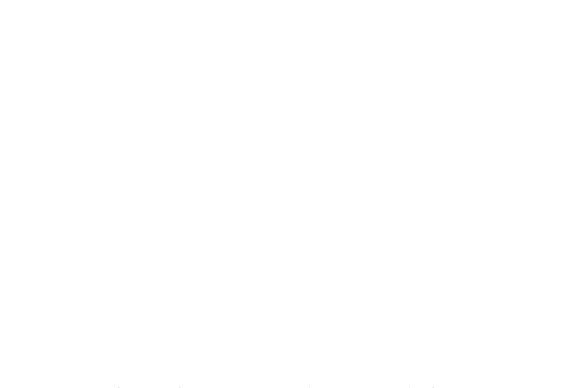
Figure 7. Randomly generated information spots. Through KMEANS (MATLAB) the spots were clustered into several sets. The input for ACO is the center of each set, and the input for GLNS is all the clustered